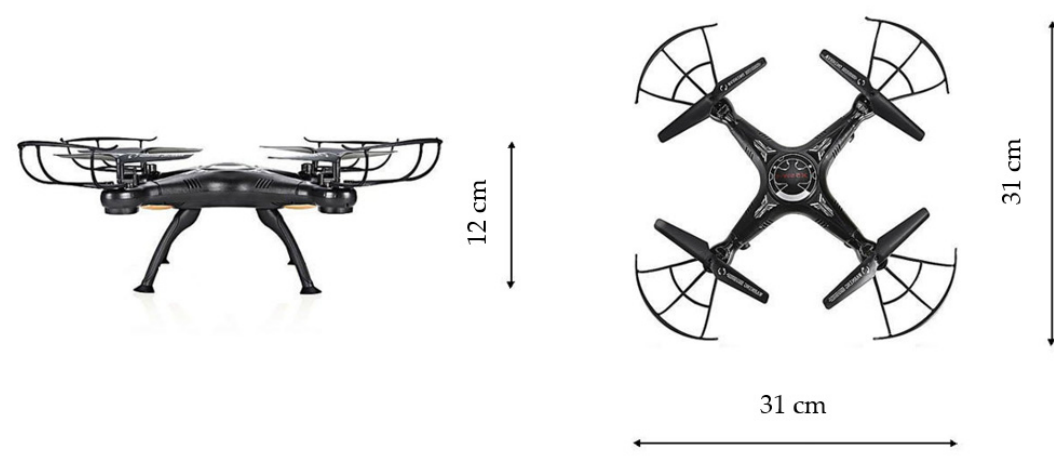
Figure 1. Front and top view and dimensions of the unmanned aerial vehicle (UAV) used.